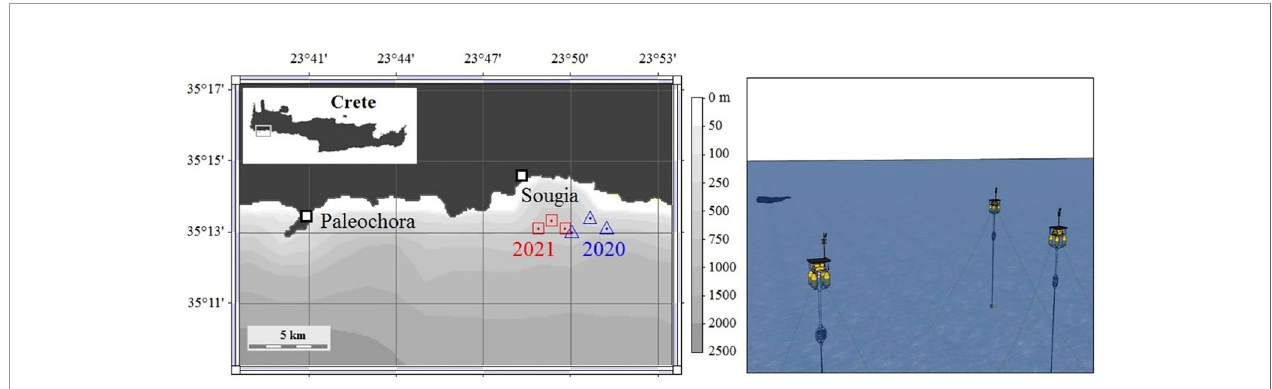
FIGURE 3 | Left: Buoy locations of the SAvEWhales observatory in the 2020 and 2021 deployment in the Sougia Bay off SW Crete. Right: A schematic view of the anchored acoustic